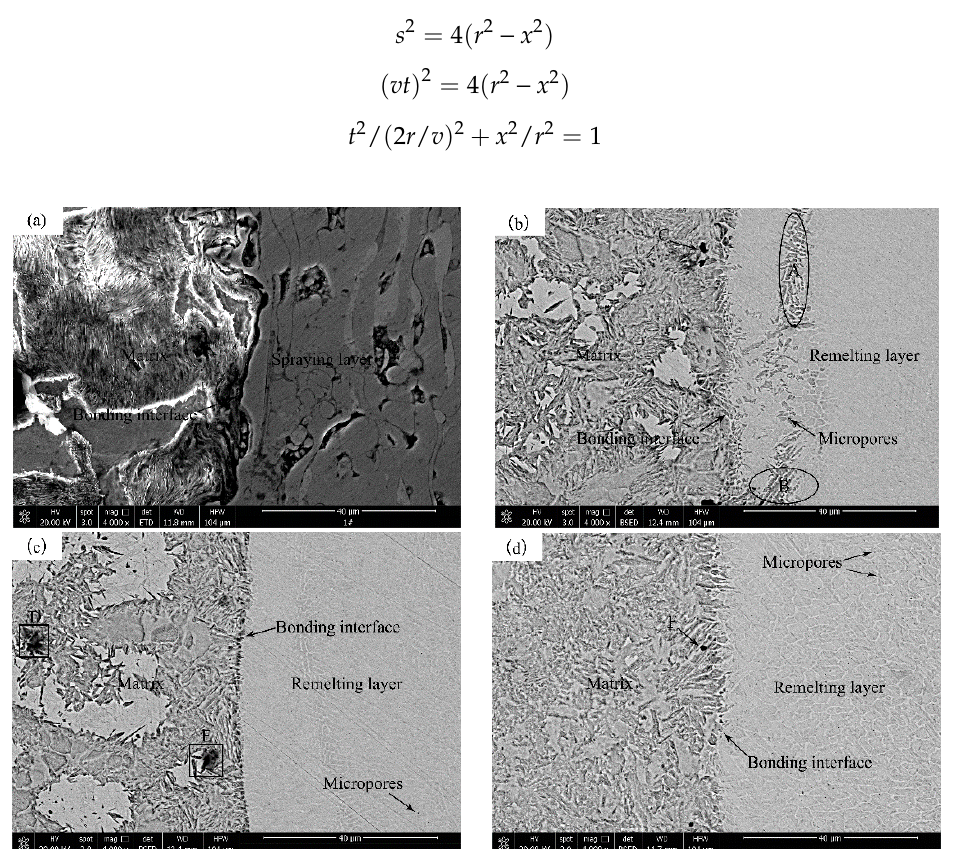
Figure 3. SEM of interface morphology at: ( a ) flame spraying; ( b ) 150 mm/min; ( c ) 200 mm/min; ( d ) 250 mm/min.